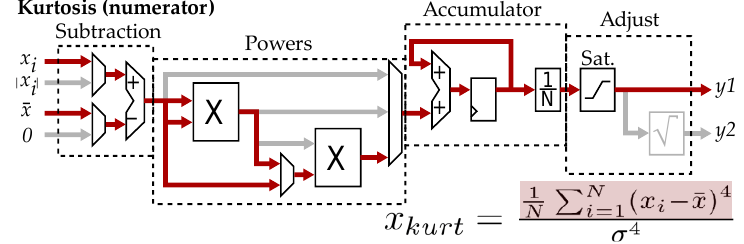
Figure 4. Calculus chain to obtain the kurtosis numerator of Equation (11).